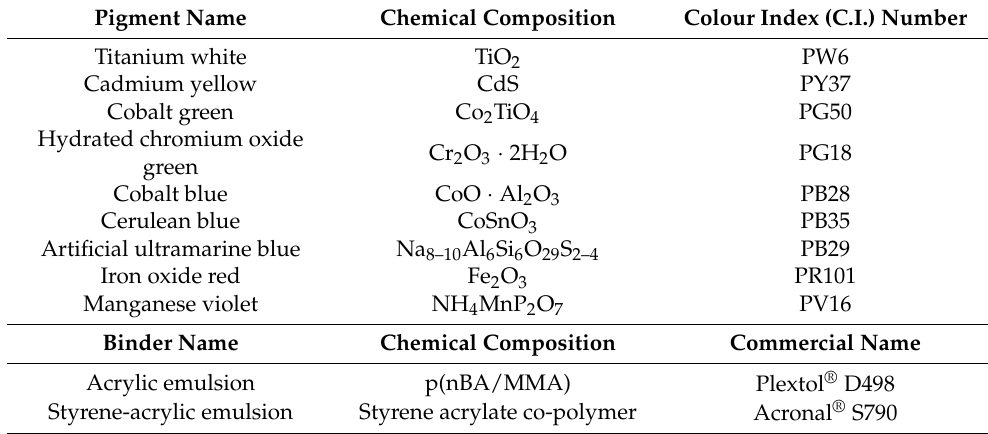
Table 1. List of materials